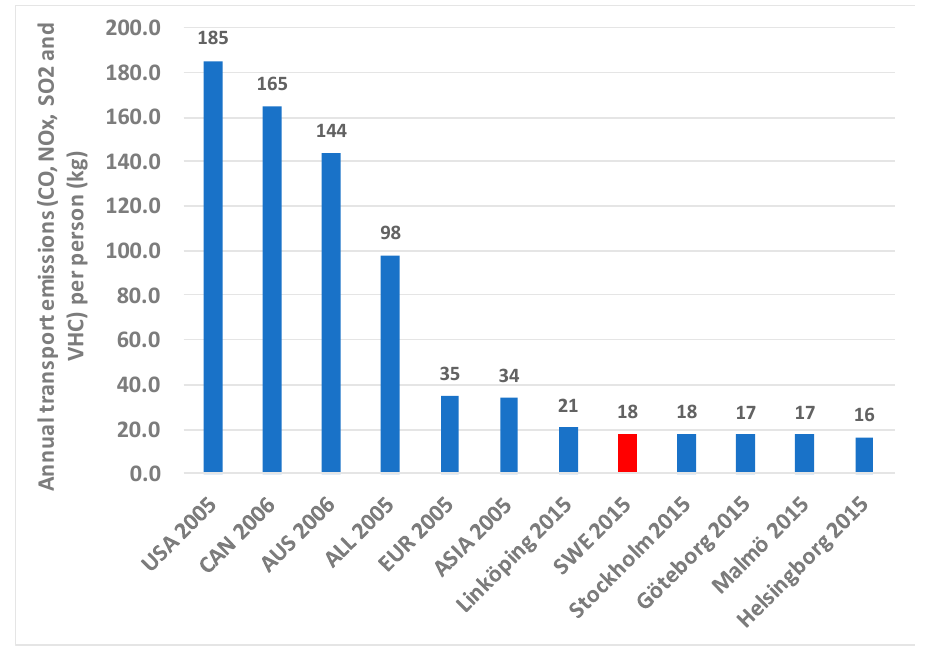
Figure 18. Annual transport emissions per person in five Swedish cities (2015) compared to a sample of global cities (2005–2006).